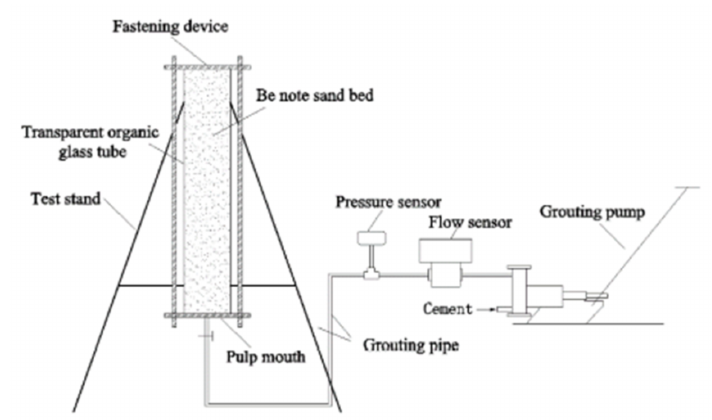
Figure 3. Grouting simulation test device.